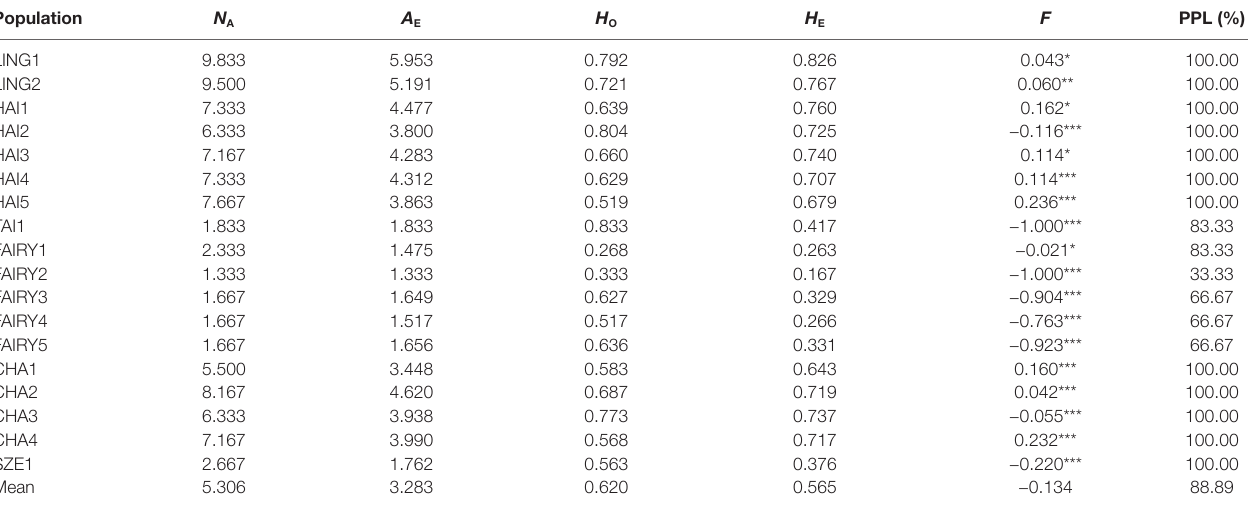
TABlE 4 | Genetic diversity parameters within populations of the Cycas taiwaniana complex based on microsatellites.